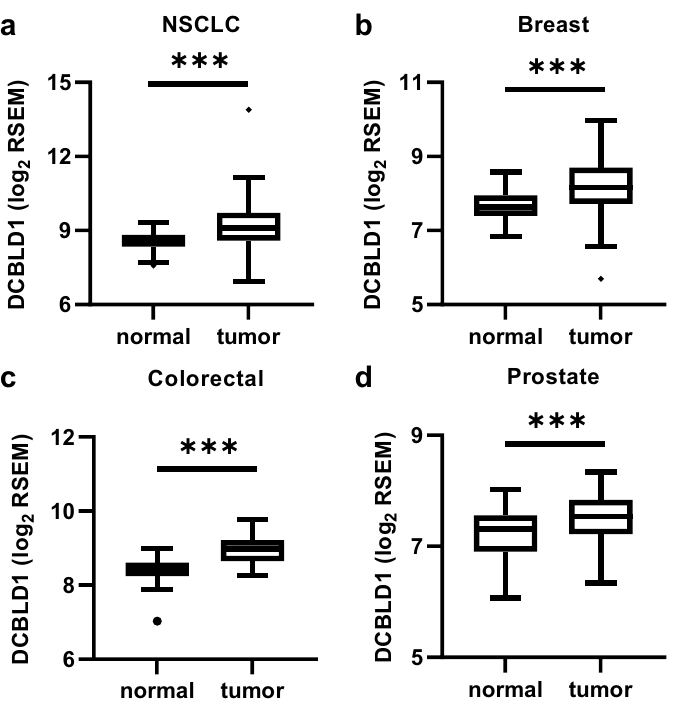
Figure 3. Evaluation of DCBLD1 expression in tumor tissue. Comparison of DCBLD1 gene expression in normal tissue adjacent to the tumor and tumor tissue for NSCLC ( A ), invasive breast carcinoma ( B ), colorectal adenocarcinoma ( C ) and prostate adenocarcinoma ( D ) TCGA cohorts.